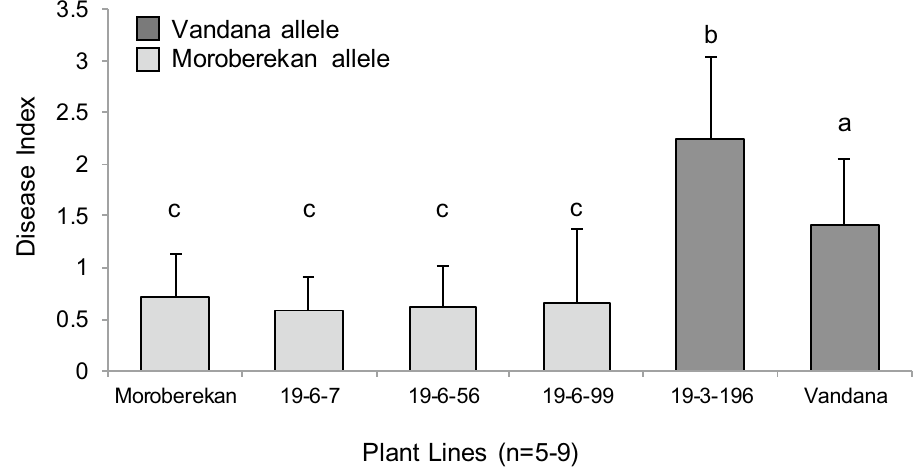
Figure 5. Performance of F 6 intermated lines with different CG genes after inoculation with R. solani strain RM01401 in greenhouse tests. Introgressed lines with multiple CGs, particularly those with OXO, are more resistant than lines with few CGs. Line number (CG content): 19-6-7-B-B (OXO, HSP90, POX); 19-6-56-B-B (Chitinase, OXO, POX, GLP); 19-6-99-B-B (OXO); 19-3-196-B-B